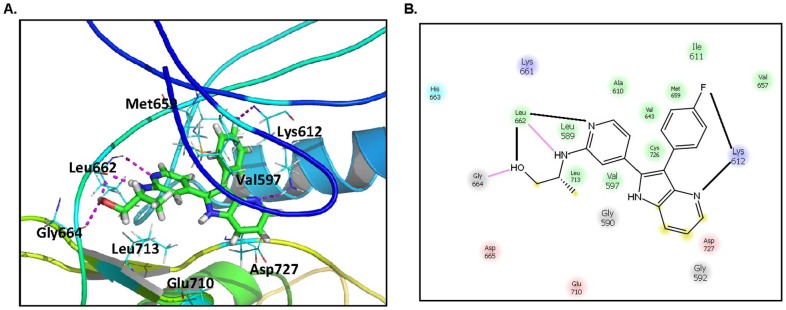
Molecular modeling of compound 139 in the active site of a PKD1 homology model.
A. The docking result of the bioactive compound 139 in the ATP binding site of the PKD1 kinase domain. carton ribbon and thick line, PKD1; ball and stick, Compound 139; thin line, residues in the binding pocket; magenta line, hydrogen bond. B. The proposed key contacts in the active site. purple line, hydrogen bond; residues in different colors: purple, basic; pink, acidic; green, hydrophobic; gray, hydrophilic.